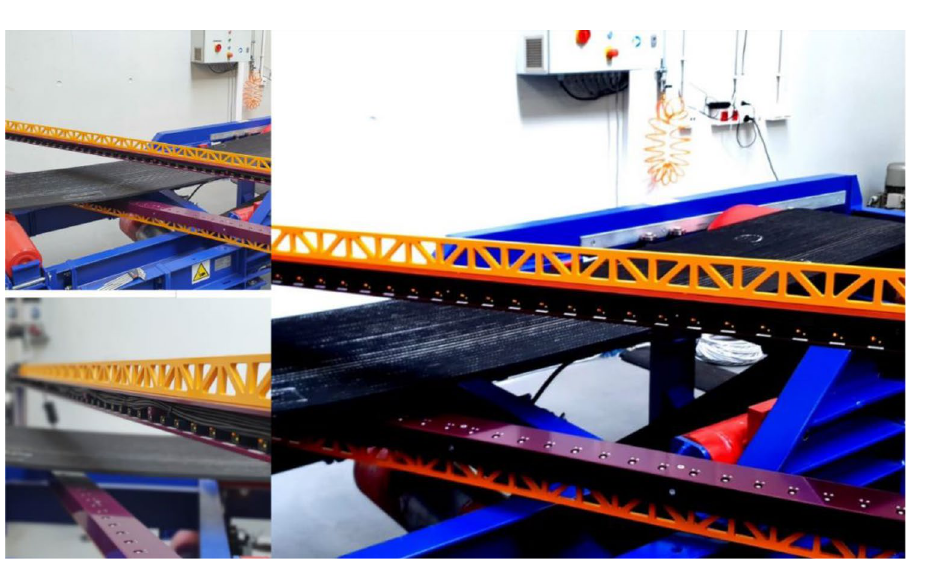
Figure 11. Measurements on the test